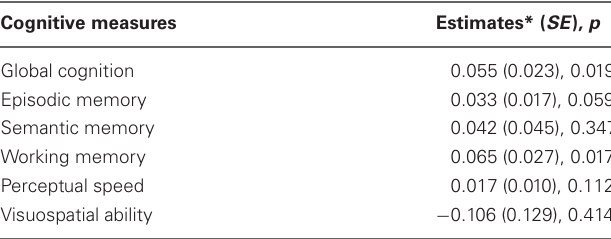
Table 2 | Pre-scan rate of change in cognition and hippocampal volume.